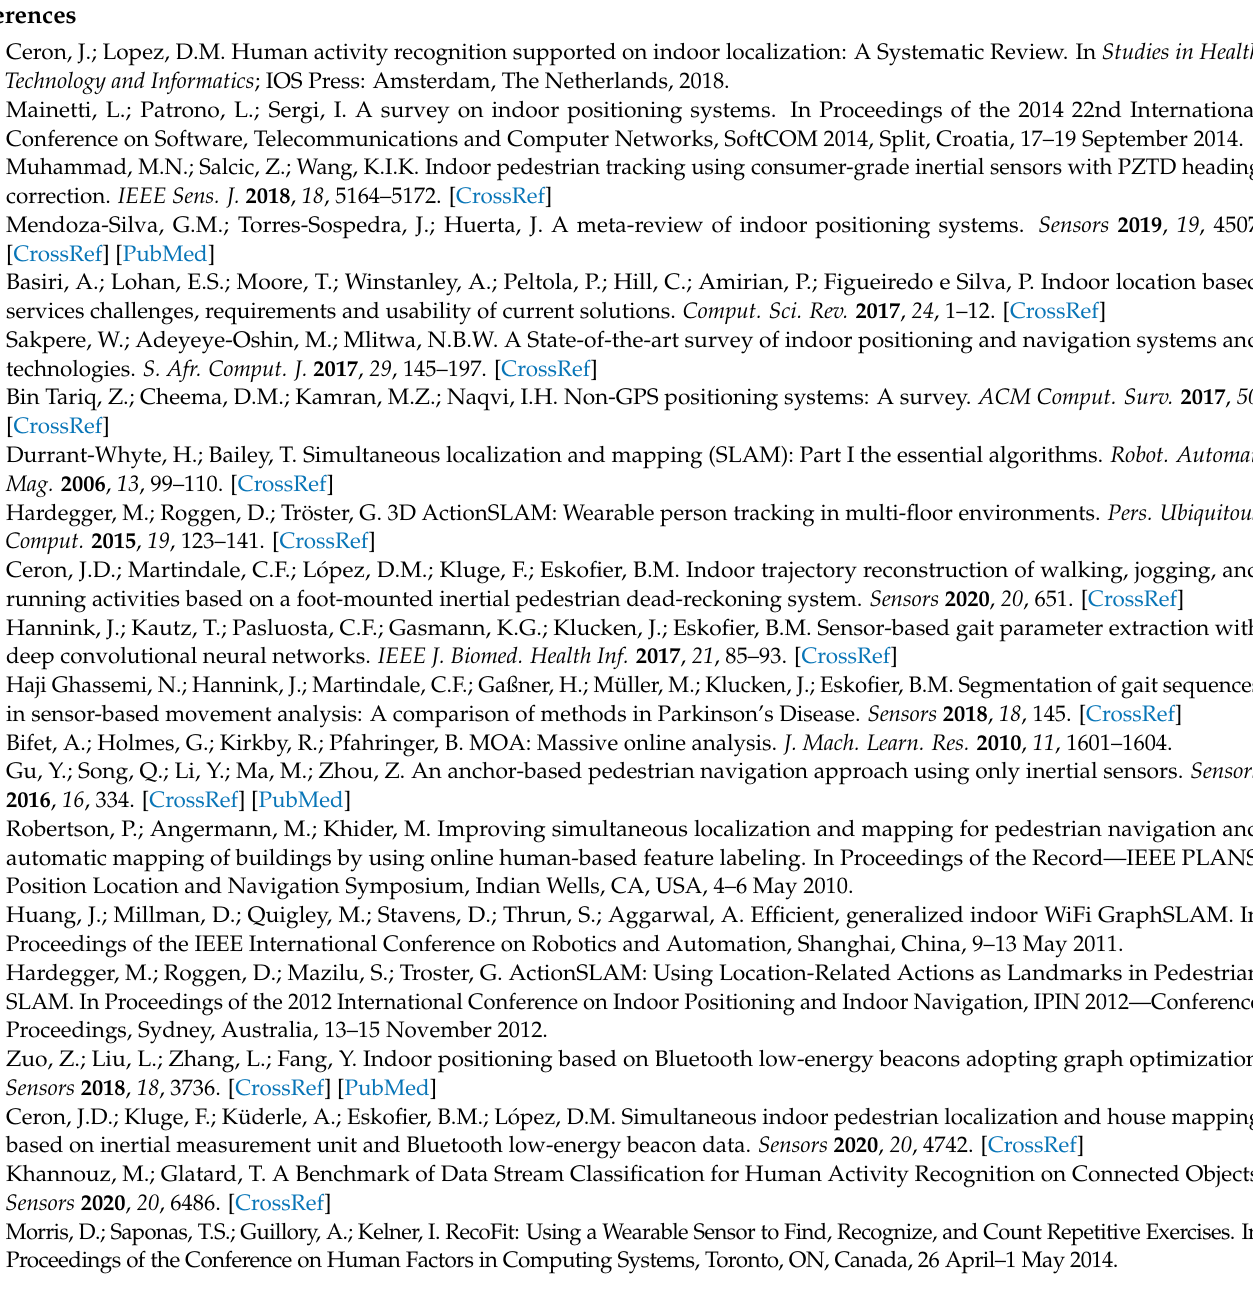
Figure A4. Indoor localization results (control group, participants 7–11).